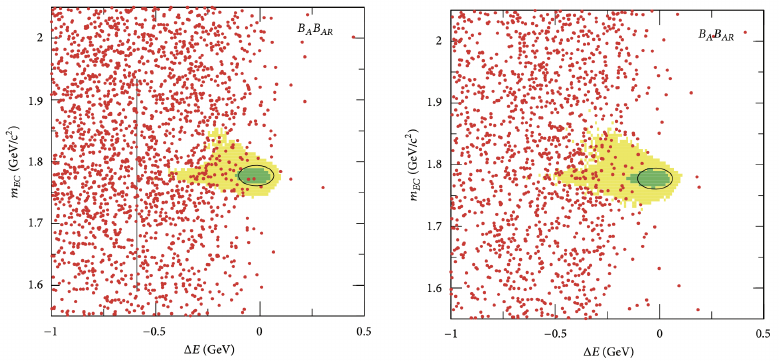
Figure 21. The Grand Signal Box and the 2 σ ellipse for τ ± → e ± γ ( left ) and τ ± → µ ± γ ( right ) decays in the m BC vs. ∆ E plane. Data are shown as dots, and contours containing 90% (50%) of signal MC events are shown as light-shaded (dark-shaded) regions (Figure and caption from [140]). The searches yield no evidence of signals, and the experiment set upper limits on the branching fractions of B ( τ ± → e ± γ ) < 3.3 × 10 − 8 and B ( τ ± → µ ± γ ) < 4.4 × 10 − 8 at